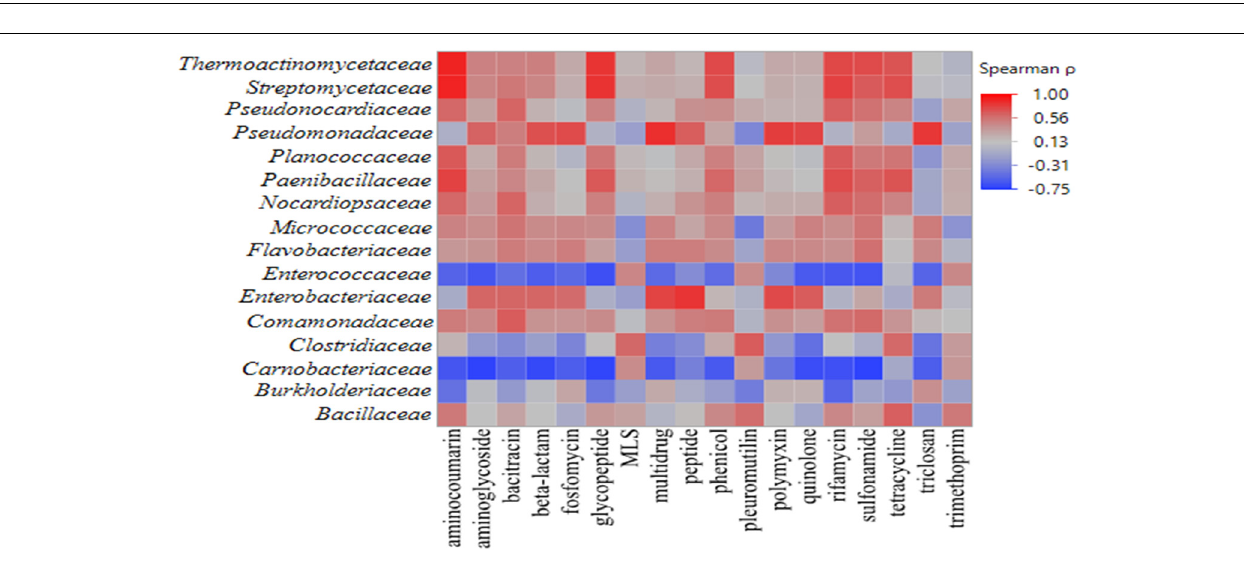
FIGURE 4 | Heat map of Spearman’s rank correlation coefficients obtained when comparing relative abundances of bacterial families and ARG classes detected in the irradiated and non-irradiated lettuce phyllospheres via 16S rRNA gene amplicon sequencing and shotgun metagenomic sequencing, respectively ( n = 22). Intensity of shading from blue to red indicates strength of correlation from negative to positive,